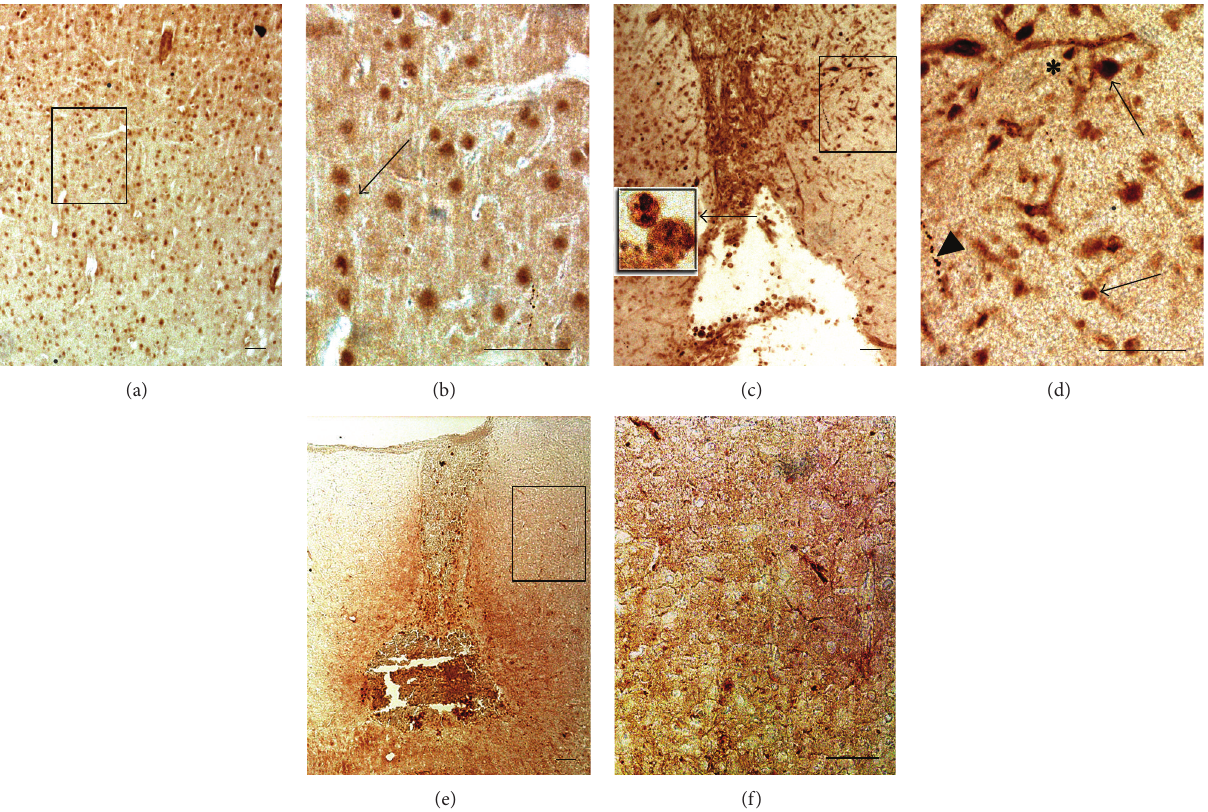
Figure 5: Repetitive HBOT affects CD40 expression after CSI. ((a) and (b)) In control cortical sections CD40 is expressed on neuron- like cells. (c) CSI increased CD40 immunoreactivity in the perilesioned cortex. ((c) inset) High magnification photomicrograph depicts a typical neutrophil with round morphology and multiple nuclei (left up corner of inset), while the enlarged cell in the right corner of inset is probably activated microglia. (d) CD40-positive dark-stained pyknotic neurons, transected axonal processes (denoted with arrows), nerve fiber varicosities (arrow head), and blood vessels (asterisk) were abundantly present in perilesioned area. ((e) and (f)) 10 days of HBOT significantly reduced CD40 immunoreactivity in the injured cortex. Rectangles indicate where the high magnification images are taken from. Scale bar = 50 𝜇 m.